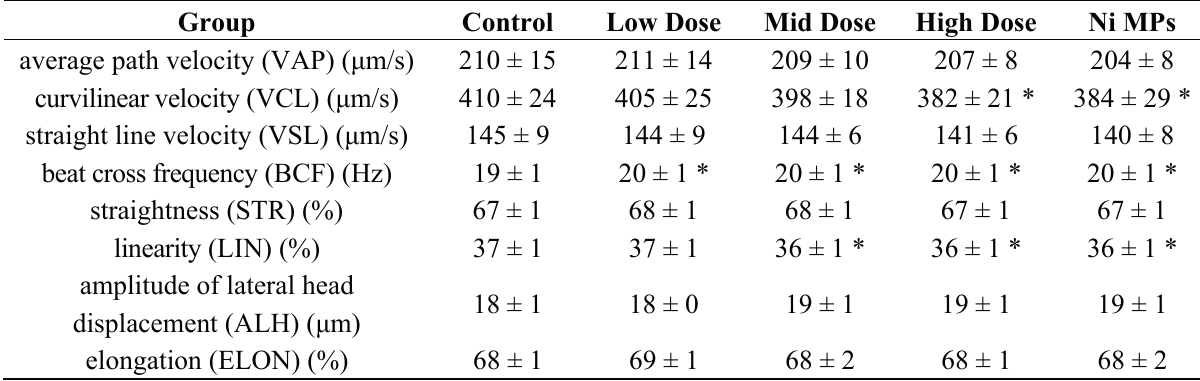
Table 2. Effects of nickel nanoparticles (Ni NPs) on rat sperm motility. Group Control Low Dose Mid Dose High